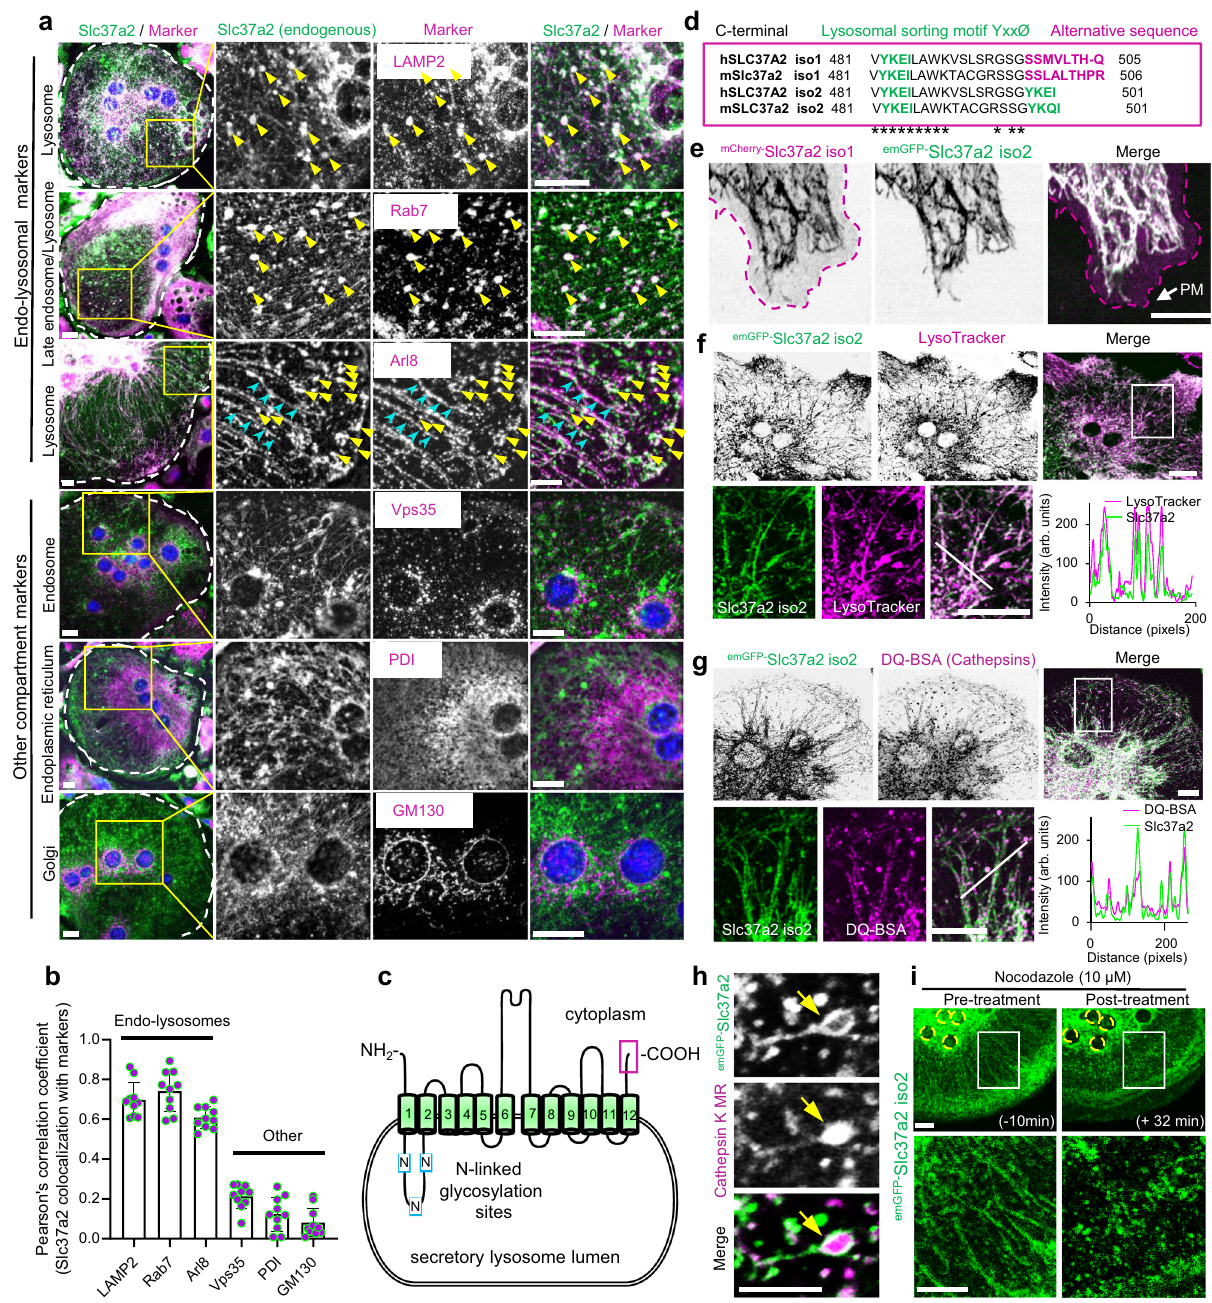
Fig. 3 | Slc37a2 localizes to a network of tubular secretory lysosomes. a Endogenous localization of Slc37a2 in mouse bone marrow monocyte (BMM)- derivedosteoclasts.Slc37a2co-localizeswithlateendo-lysosomalmarkers(LAMP2, Rab7,and Arl8),butnotwithendosomes(Vps35), theendoplasmicreticulum(PDI) ortheGolgi(GM130).Bar,10 µ m. b Pearson ’ scorrelationcoef fi cient(Rr)calculated from10osteoclastspooledfromtwoindependentexperiments.Dataarepresented as means±SD. c Schematic of Slc37a2 structure and topology on SL membranes, with transmembrane (green cylinders), luminal cytosolic domains (black lines), N-linkedglycosylationsites(blueboxes,N),andextremeC-terminus(magentabox) indicated. d Amino acid alignment of the far C-terminus for human SLC37A2 and mouse Slc37a2 isoforms (1 and 2) with lysosomal sorting motifs and alternative sequencesindicated.Asterisksindicateconservedaminoacids. e Confocalimageof amouseosteoclastculturedonglassco-microinjectedwith mCherry- Slc37a2isoform1